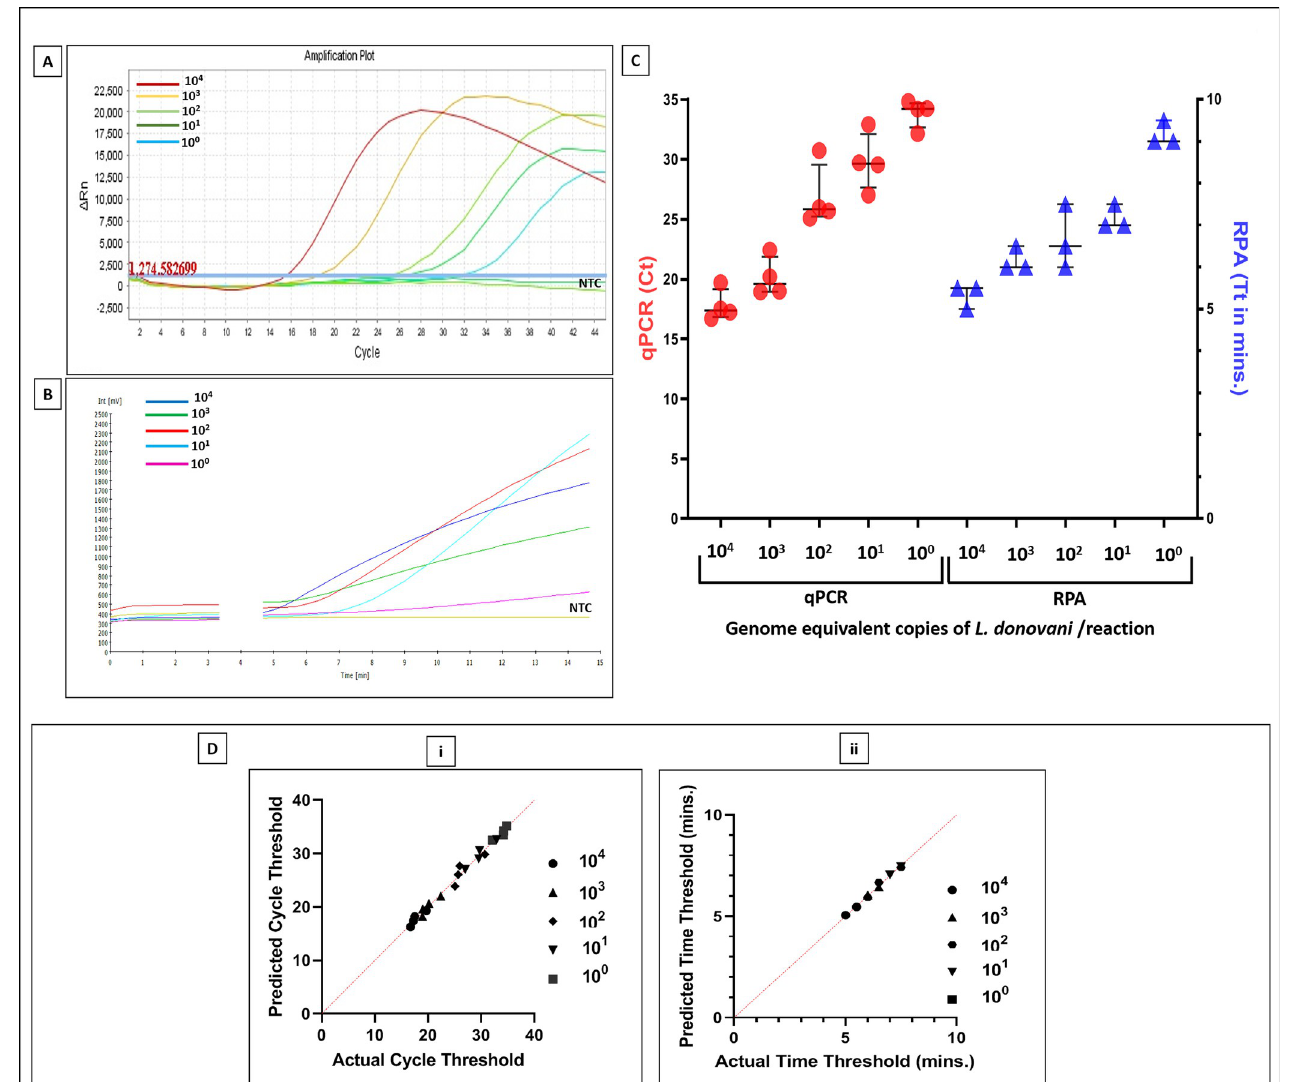
Fig 2. Standard curves for performing qPCR and RPA. A & B. Representative amplification curves of qPCR ( A ) and RPA ( B ) runs using serial dilutions (10 4 − 10˚ parasites) of molecular standard derived from a L . donovani strain together with a non-template control (NTC). Curves were generated for cycle threshold, Ct (cycle number) and time threshold, Tt (minutes) by ABI StepOne software v2.3 and ESEquant tubescanner software, respectively. The drop or gap in RPA ( B ) for the fluorescence signal after three minutes was due to the mixing step, which is necessary to produce a homogenous RPA reaction to increase the assay’s sensitivity as described in materials and methods. C . Scatterplots from qPCR ( ● ) and RPA ( ▲ ) showing cycle threshold, Ct and time threshold Tt, respectively; the horizontal bar indicates the median (IQR) values. D . The quantile-quantile (Q-Q) plot between predicted and actual Ct ( i ) and Tt ( ii